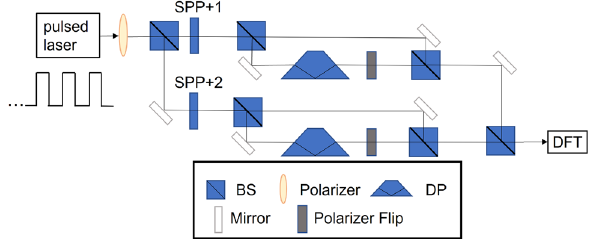
Figure 3. Optical path diagram of modular exponentiation in Shor’s algorithm. A laser pulse train passes through a polarizer and SPPs to generate the OAM modes of Laguerre–Gaussian beams, which refer to different states in the algorithm. The DPs, polarizer flips, and BSs are used to execute the algorithm. BS indicates 50/50 beam splitters, SPP spiral phase plates, and DP Dove